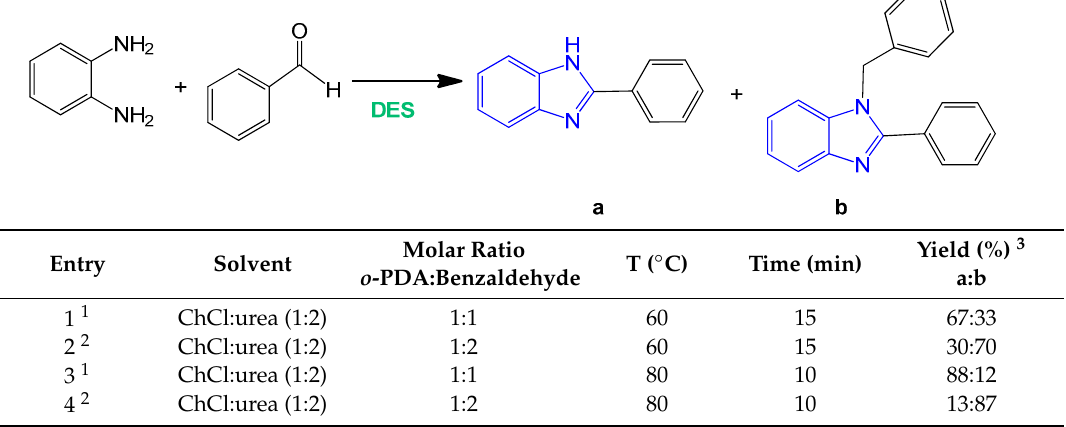
Table 1. Optimization of the reaction conditions in pilot reaction.